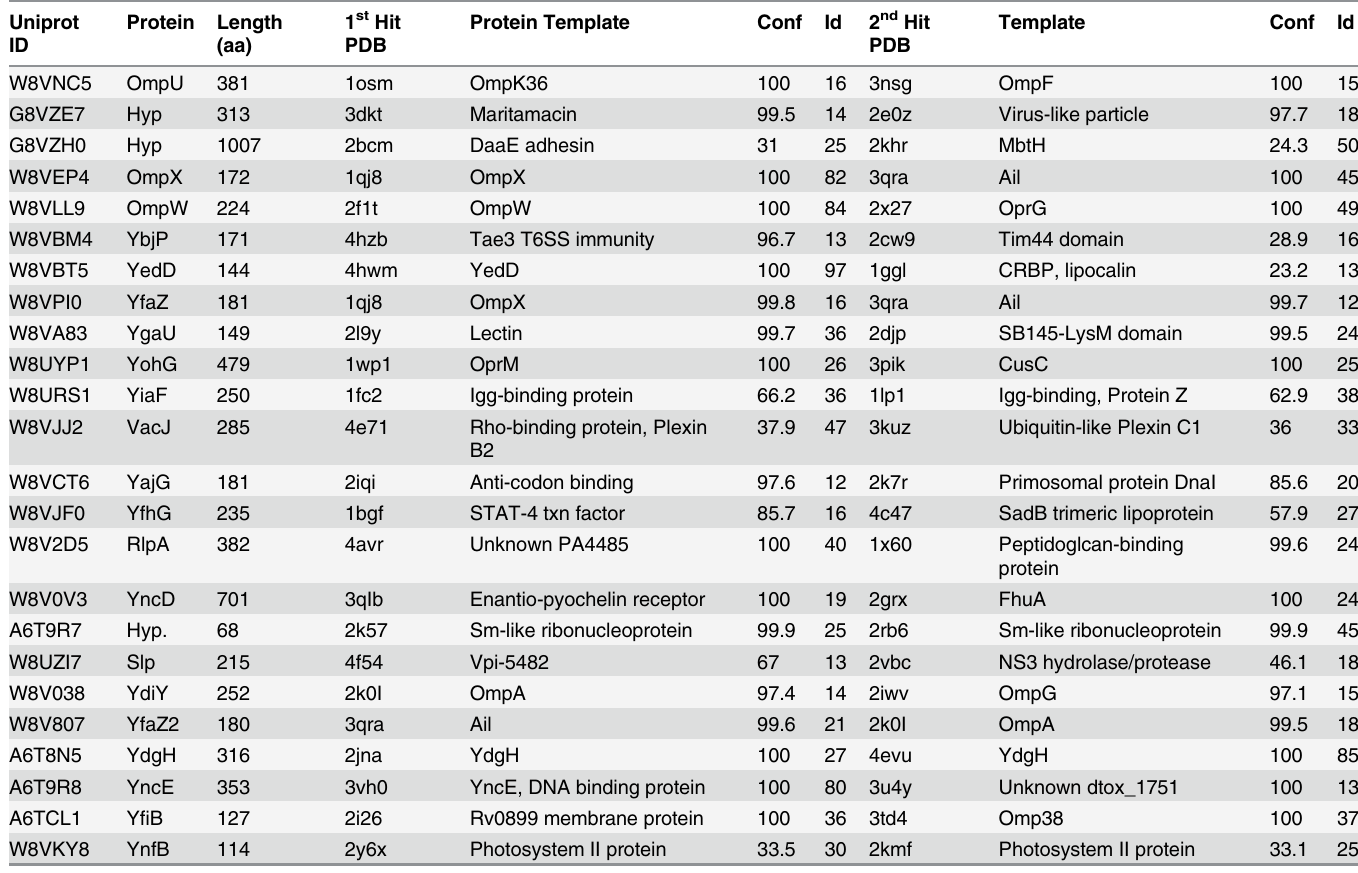
Table 2. Phyre structural predictions for K . pneumoniae hypothetical